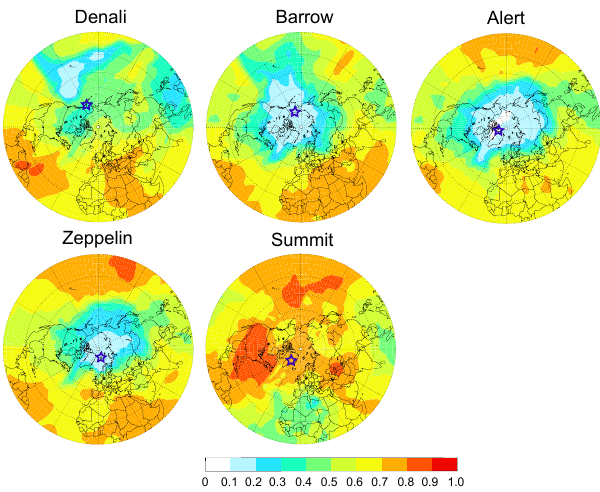
Figure 9. Reduction of adjoint sensitivities of BC concentration at selected Arctic sites (Fig. 1) to Northern Hemisphere emissions in the absence of WBF relative to standard simulation, averaged for the whole simulation period of 1 March–25 April